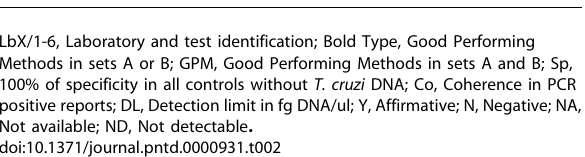
LbX/1-6, Laboratory and test identification; Bold Type, Good Performing Methods in sets A or B; GPM, Good Performing Methods in sets A and B; Sp, 100% of specificity in all controls without T. cruzi DNA; Co, Coherence in PCR positive reports; DL, Detection limit in fg DNA/ul; Y, Affirmative; N, Negative; NA,